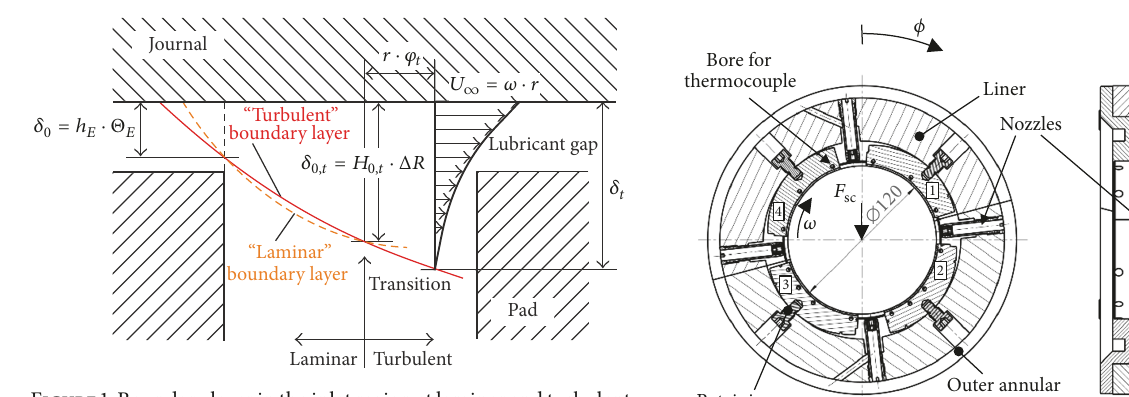
Figure1:Boundarylayerintheinletregionatlaminarandturbulent flow according to [1].